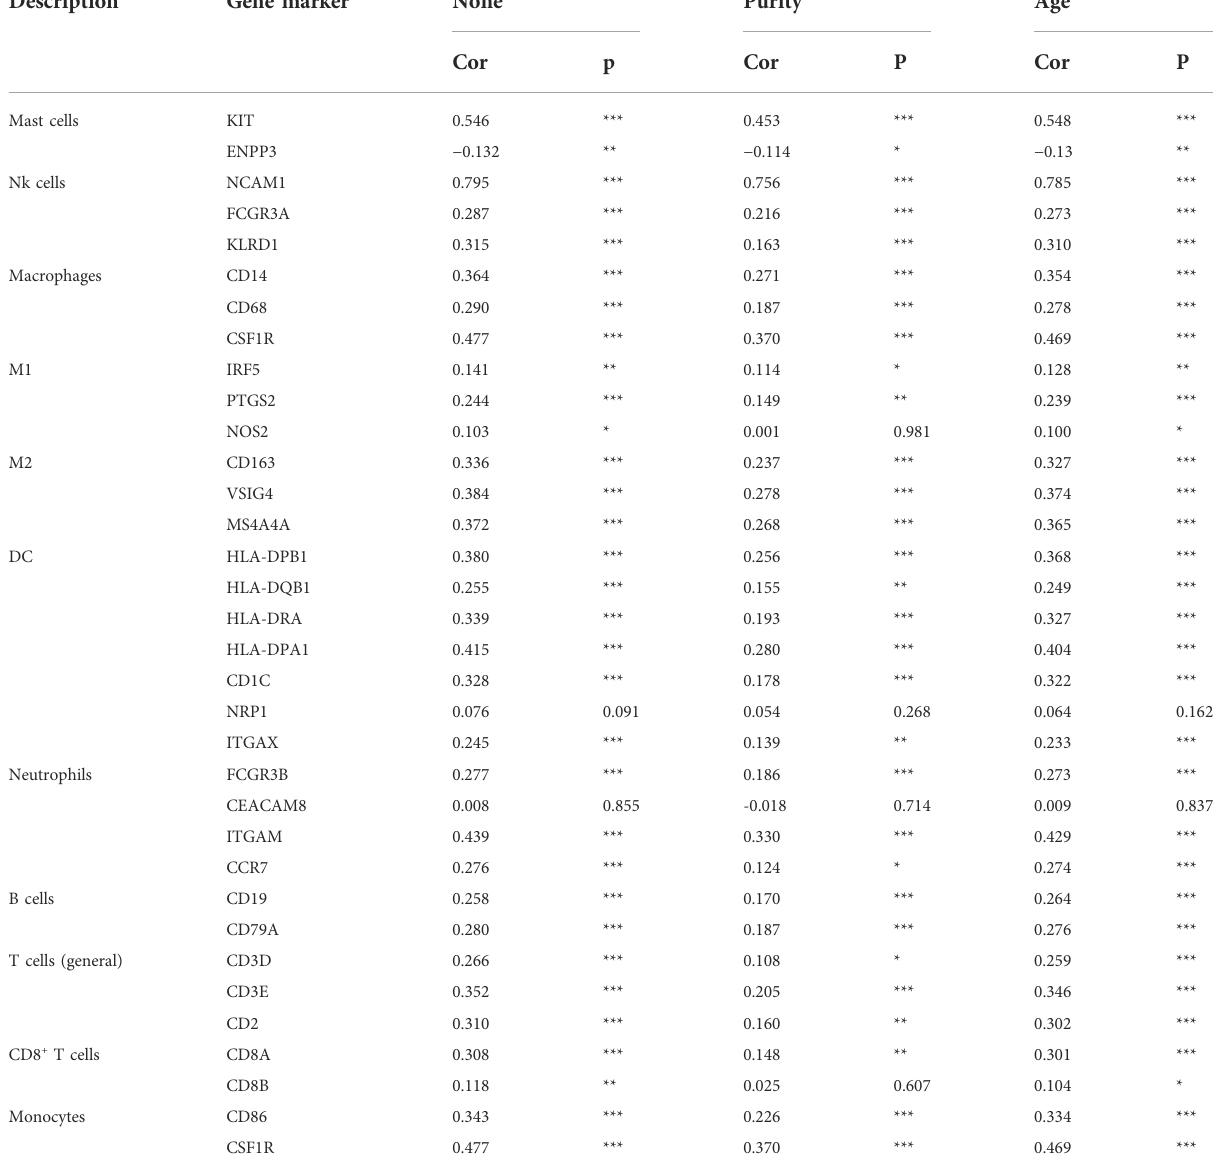
TABLE 1 Correlation analysis between LMO3 and gene markers of immune cells in TIMER.